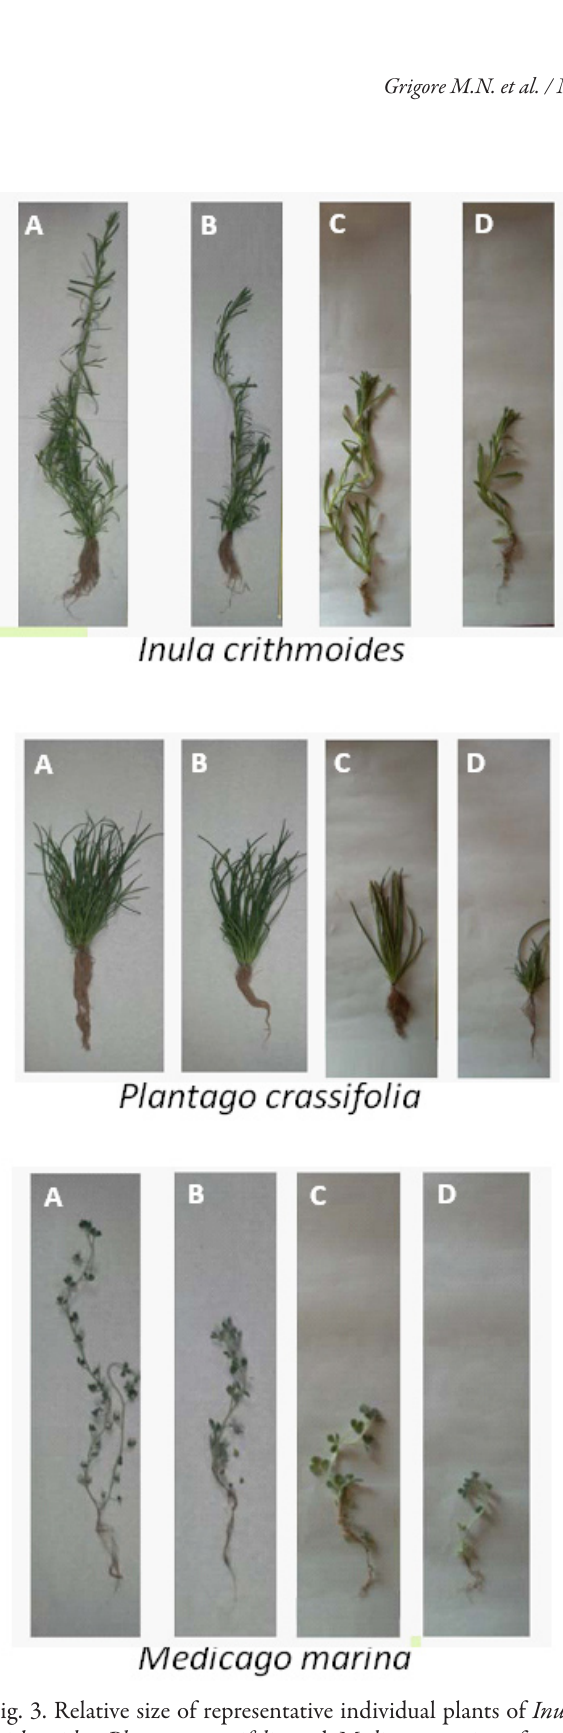
Fig. 3. Relative size of representative individual plants of Inula crithmoides , Plantago crassifolia and Medicago marina after 12 weeks of growth in different substrates: peat (A), garden soil (B), saline soil (C) and dune sand (D); note that plants of the differ- ent species are not shown at the same